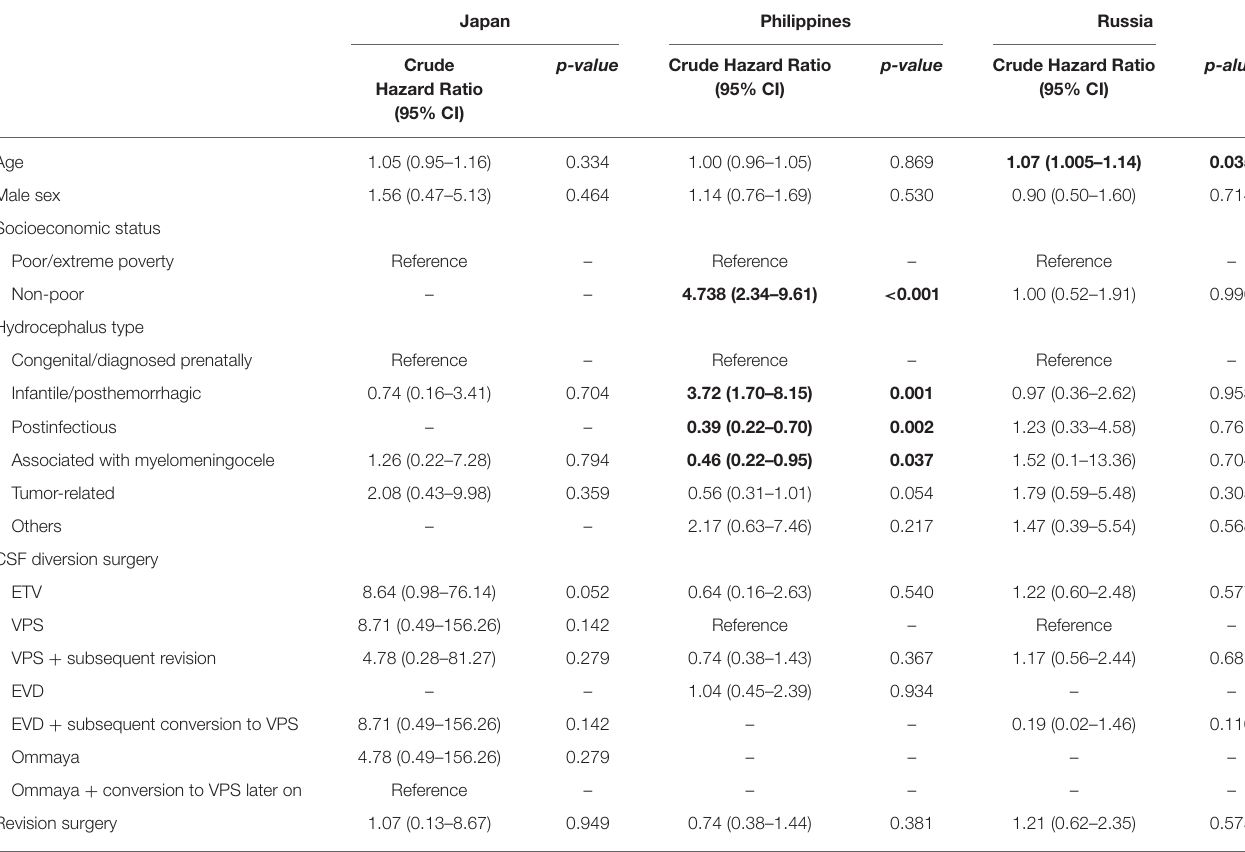
TABLE 3 | Determinants of the timing of CSF diversion surgery, by country, after univariate Cox